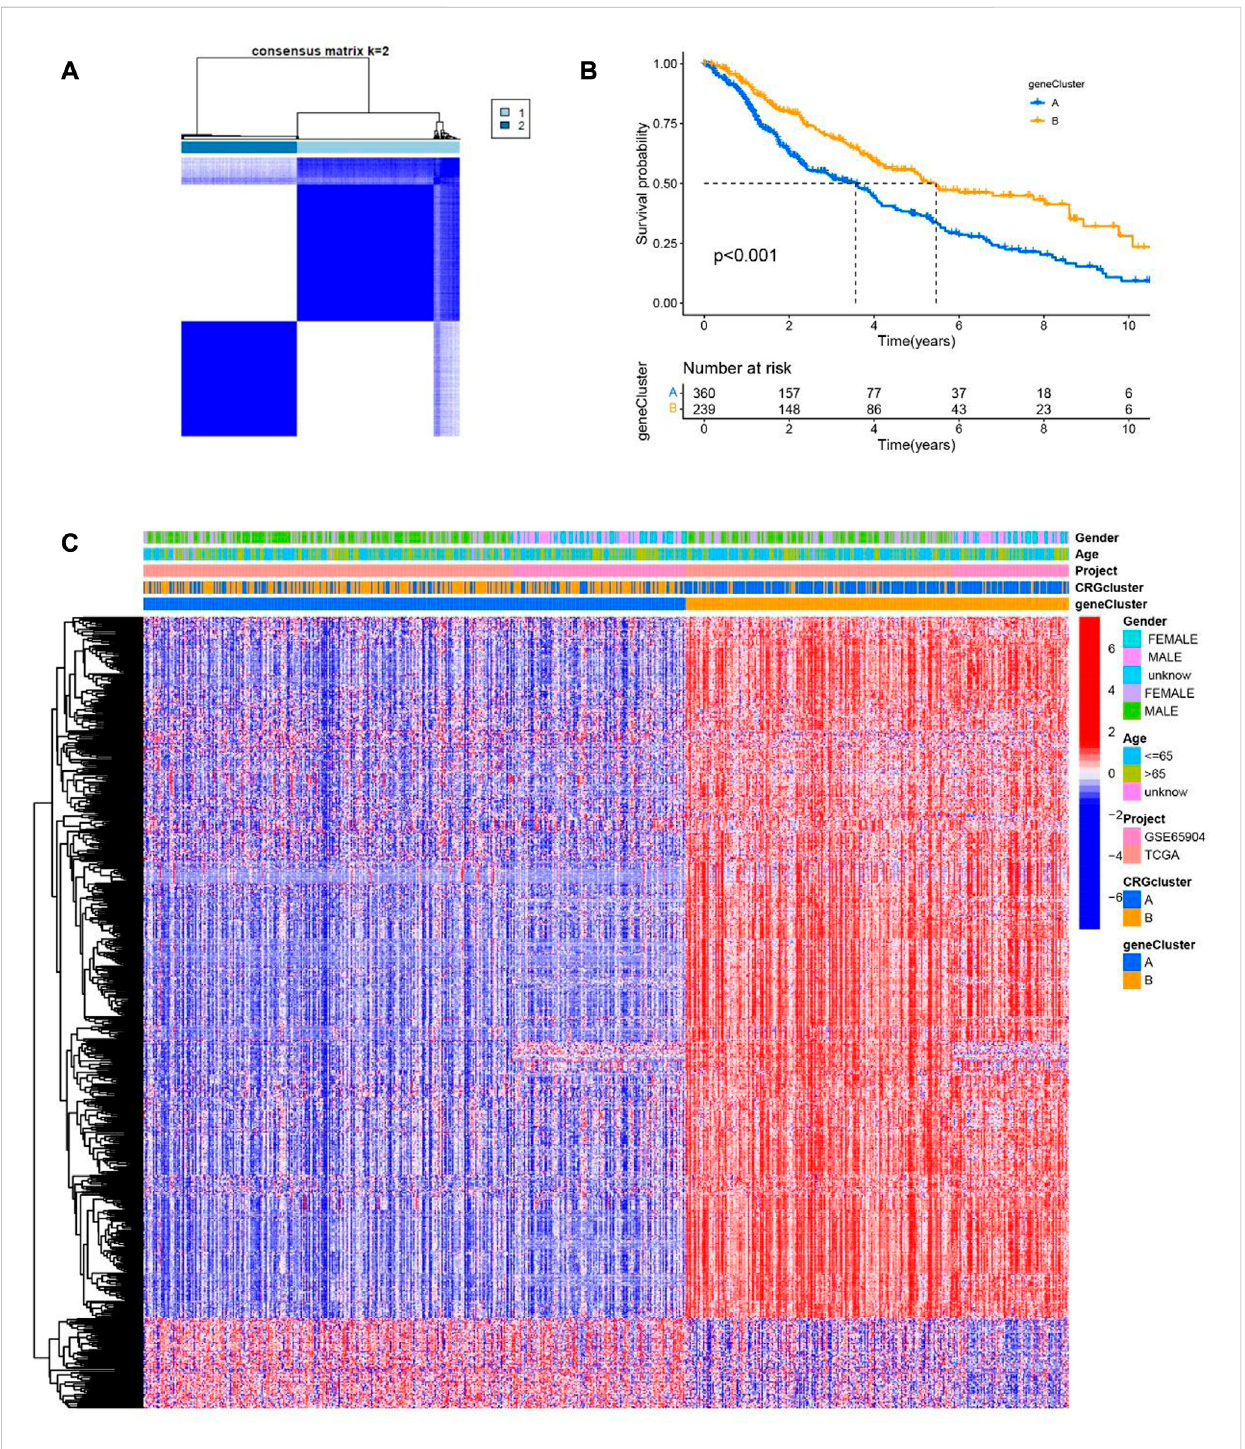
FIGURE 5 Two clusters of cuproptosis-related differential genes. (A) The Consensus matrix heatmap de fi ned two clusters based on the consistency of cuproptosis-related differential genes expression (K = 2). (B) Compare the survival time of two clusters through KM survival analysis. (C) The clinical and pathological information of two cuproptosis-related differential genes clusters are shown in the